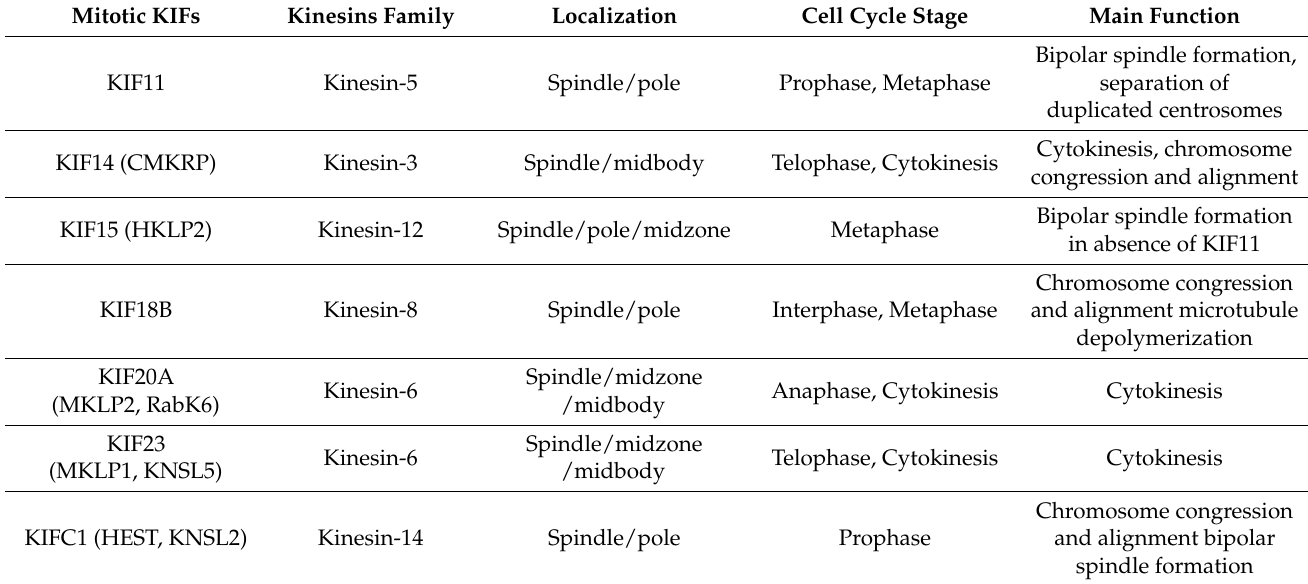
Table 3. A summary of the seven overexpressed mitotic KIFs in cell